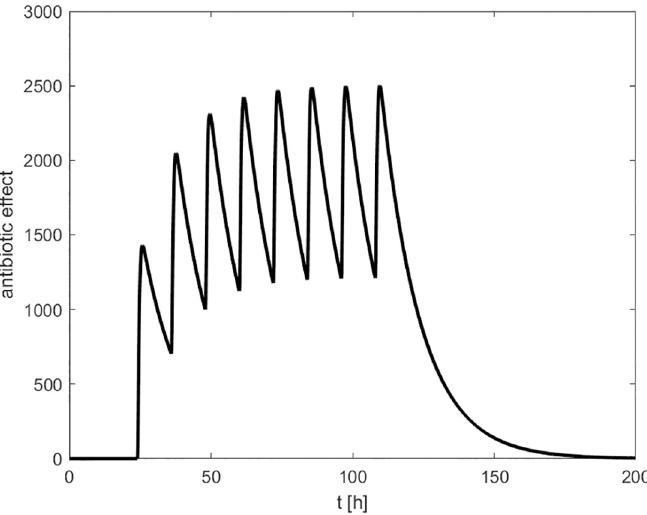
Fig 2. Antibiotic therapy. In this example, the antibiotic effect A ( t ) of repetitive drug administrations in time intervals of 12 hours is shown. Therapy starts 24 hours after infection and stops after 8 injections.